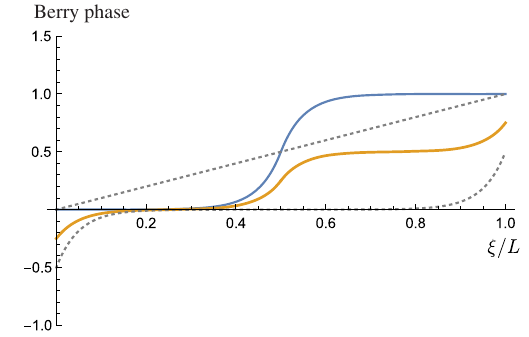
FIG. 3. The behavior of the Berry phase for ˜ Φ x Þ 00 (orange line) as a function of ξ for qL ¼ 10 and θ ð